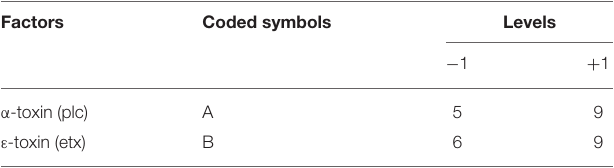
TABLE 3 | The design approach for determining the optimization of C. perfringens toxinotypes in central–composite design (CCD).